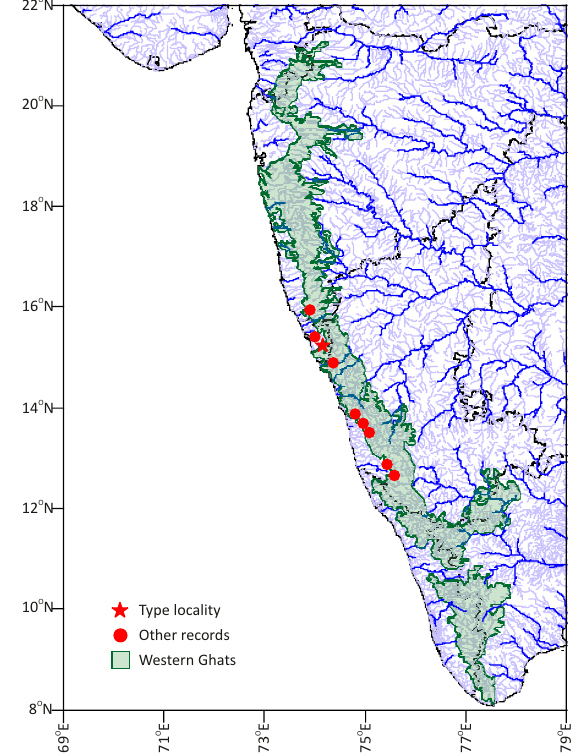
Figure 2. Distribution of Pethia setnai .